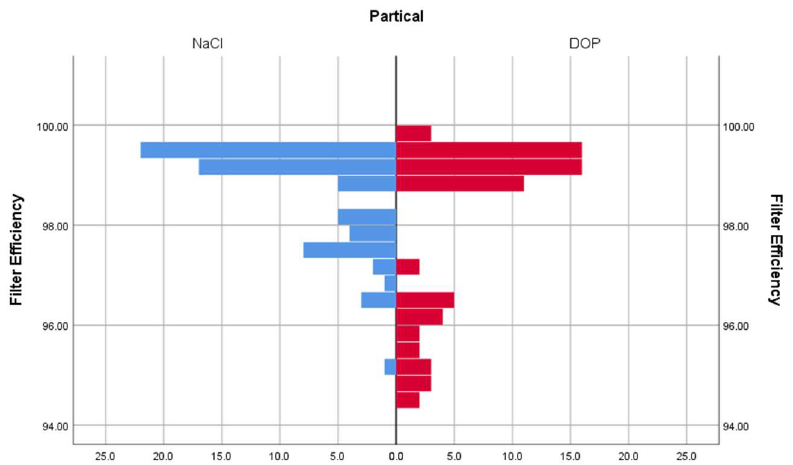
Figure 5. The bidirectional comparison histogram of the filtration efficiency of respirators treated with NaCl particles (blue) and DOP particles (red).